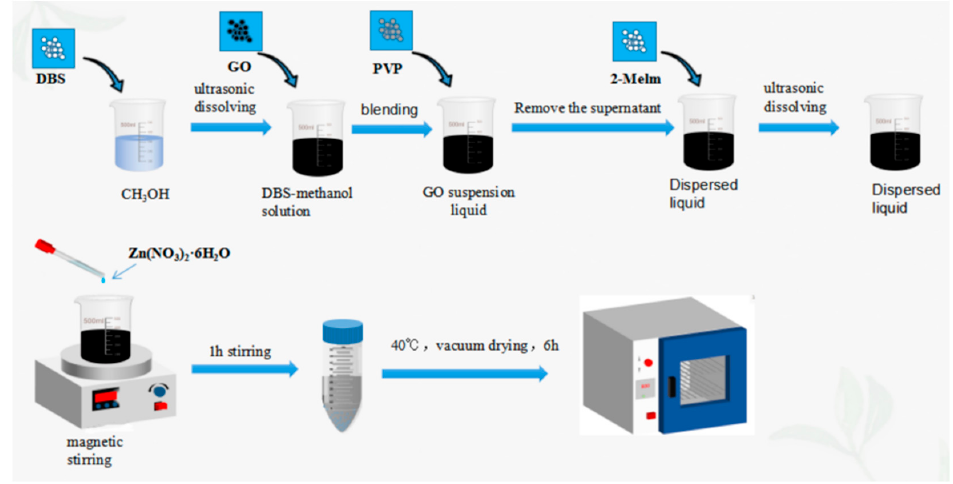
Figure 1. The preparation process of MGO@ZIF-8.